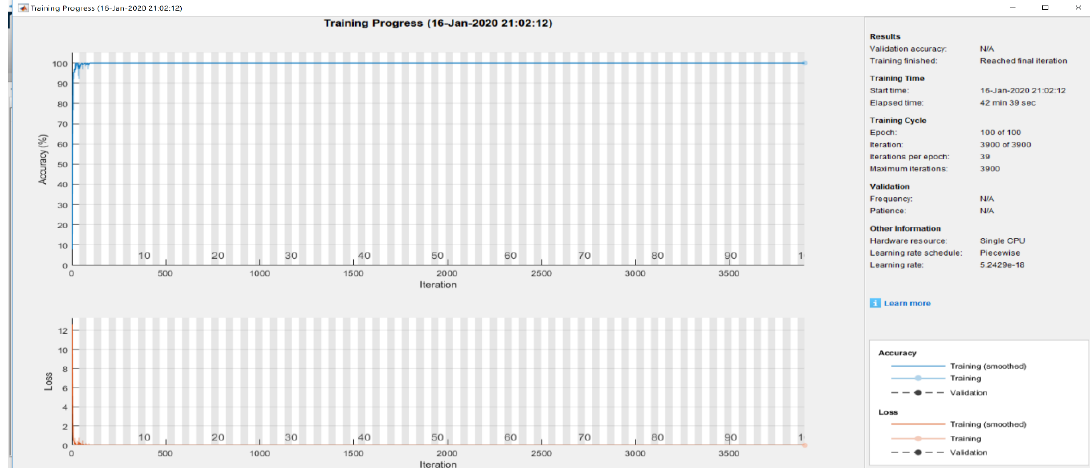
Figure 11 . Training progress. The first graph shows the training accuracy (classification accuracy) X -axis is 100 epoch and Y -axis is 3900 Iterations. The second graph is the loss function (cross entropy